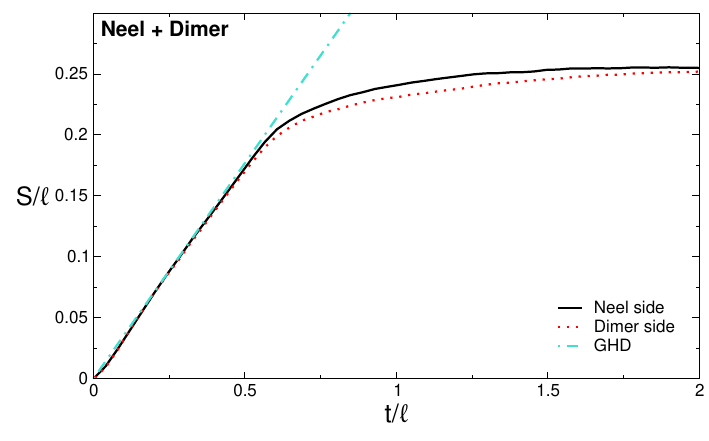
Figure 8: Dynamics of the von Neumann entanglement entropy after the quench from the initial state obtained by joining the Néel and the dimer state in the XXZ chain with ∆ = 2. The entropy density S /(cid:96) is plotted versus the rescaled time t /(cid:96) , with (cid:96) being the subsystem size. The interval is placed next to the interface between the two chains. Here we choose (cid:96) = 100, while the total chain size is L = 2000. The full and the dotted lines are the flea gas results for an interval placed in the Néel and dimer part, respectively. The results are obtained by averaging over ∼ 10000 realizations of the dynamics. The dash-dotted line is the GHD prediction (35) valid in the space-time scaling limit. Notice that the asymptotic value of the entropy at t → ∞ does not depend on the region where the subsystem is